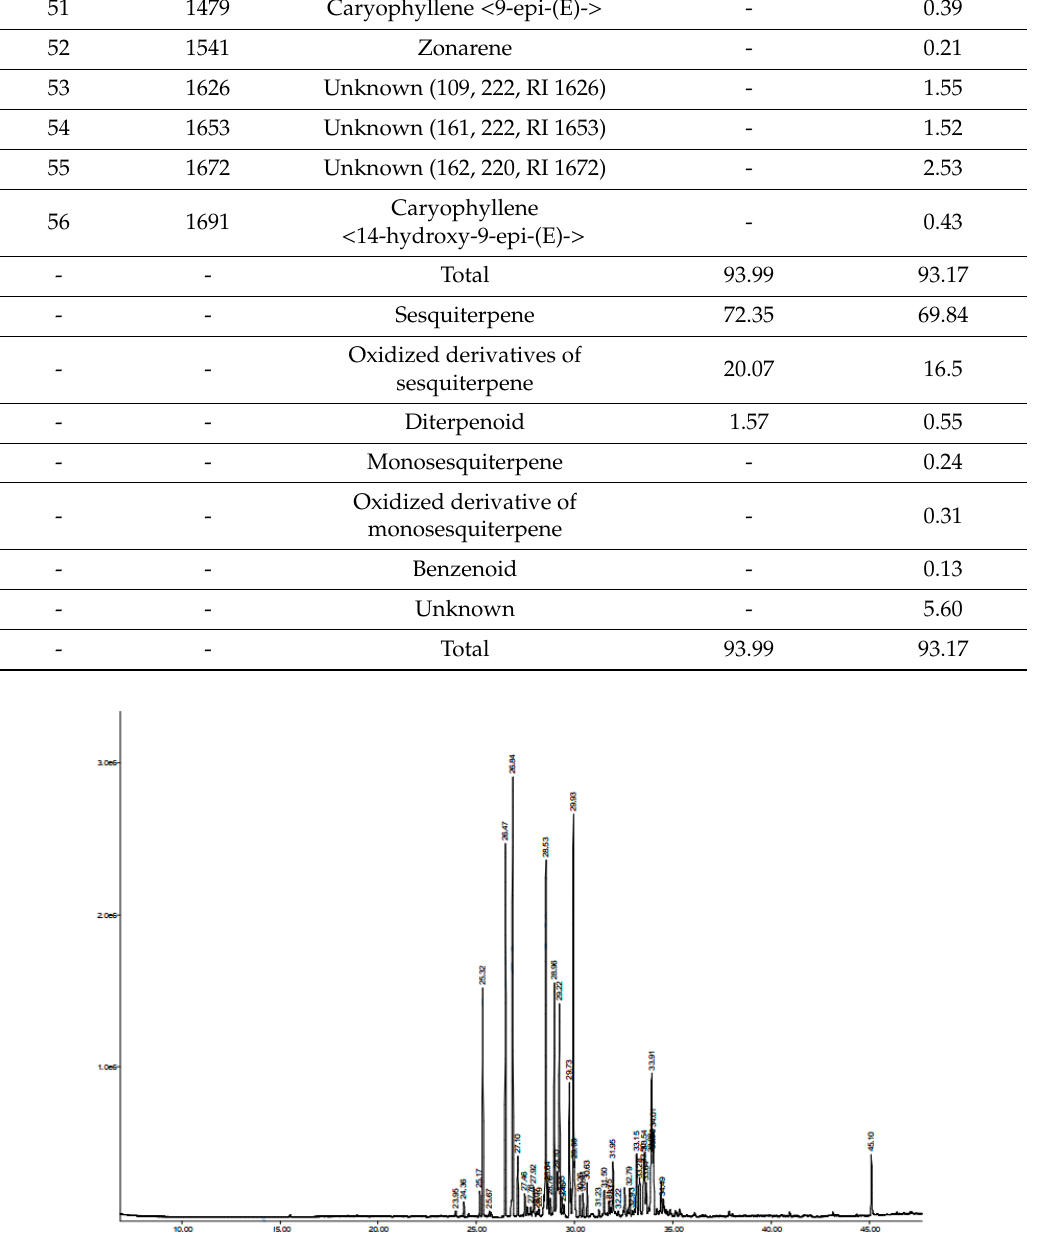
Figure 5. The chromatogram of C. candicans essential oil obtained by MAHD.